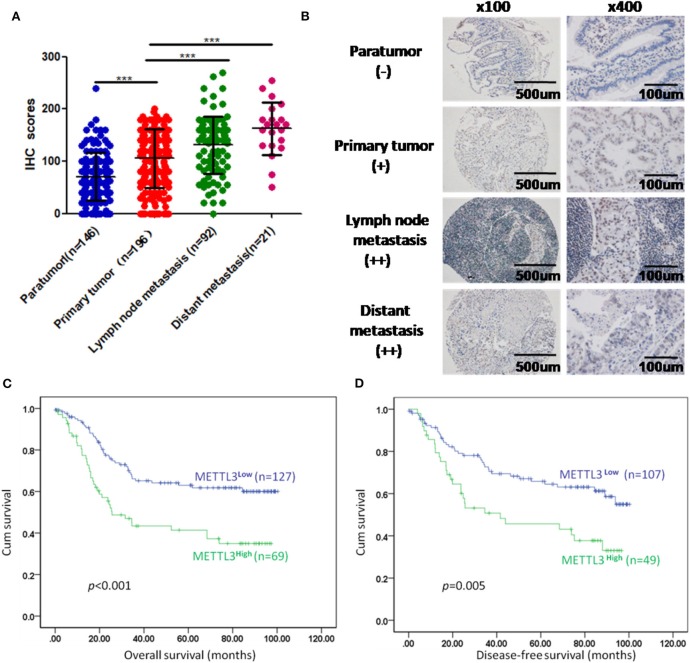
Immunohistochemistry (IHC) scores of methyltransferase-like 3 (METTL3) in different types of tissues and Kaplan–Meier survival curves in gastric cancer (GC) patients. (A) IHC scores of METTL3 in four different types of tissues from 196 patients with GC (paratumor, mean ± SD = 70.74 ± 46.29; primary tumor, mean ± SD = 105.60 ± 56.16; lymph node metastasis, mean ± SD = 130.80 ± 55.31; distant metastasis: mean ± SD = 162.6 ± 50.19). (B) Immunohistochemical staining of METTL3 in four different types of tissues from the same patient. (C) Overall survival analysis in all GC patients (n = 196). (D) Disease-free survival analysis in GC patients who were first diagnosed with tumor–node–metastasis (TNM) stage I, II, or III (n = 156). ***p < 0.001.